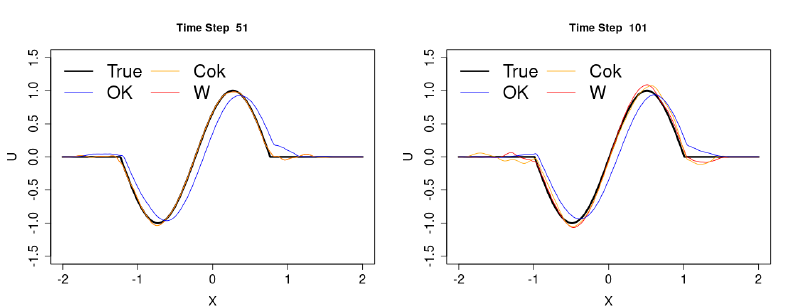
Figure 3. The left and right panels show the true and predicted waves at t 51 = 0.5 s and t 101 = 1.0 s, respectively. The black lines are the true data, and the red, orange, and blue lines are the predictions given by Schemes 1, 2, and 3, respectively.